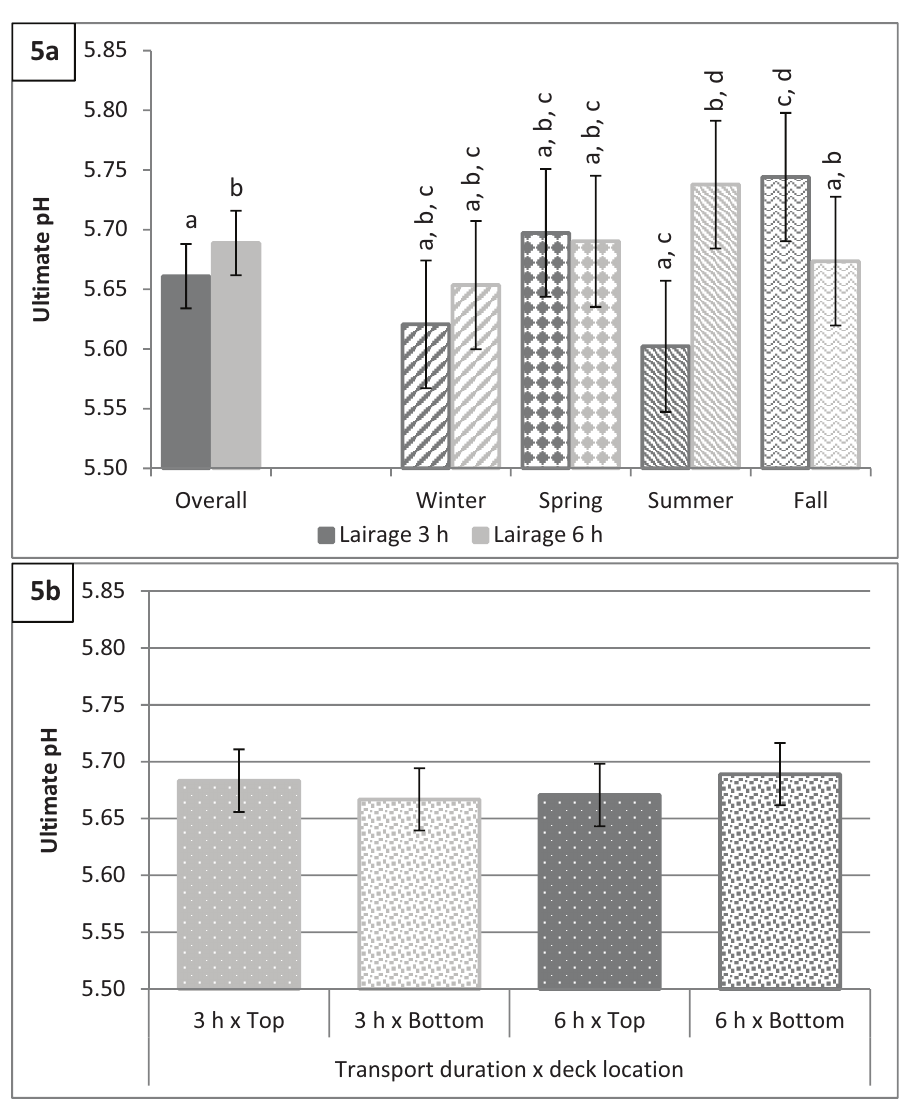
Figure 5. Ultimate pH values ( a ) by lairage duration (P = 0.005) and by season × lairage duration (P < 0.0001) and ( b ) by transport duration × deck location (P = 0.02). Values with different letters differ by P <